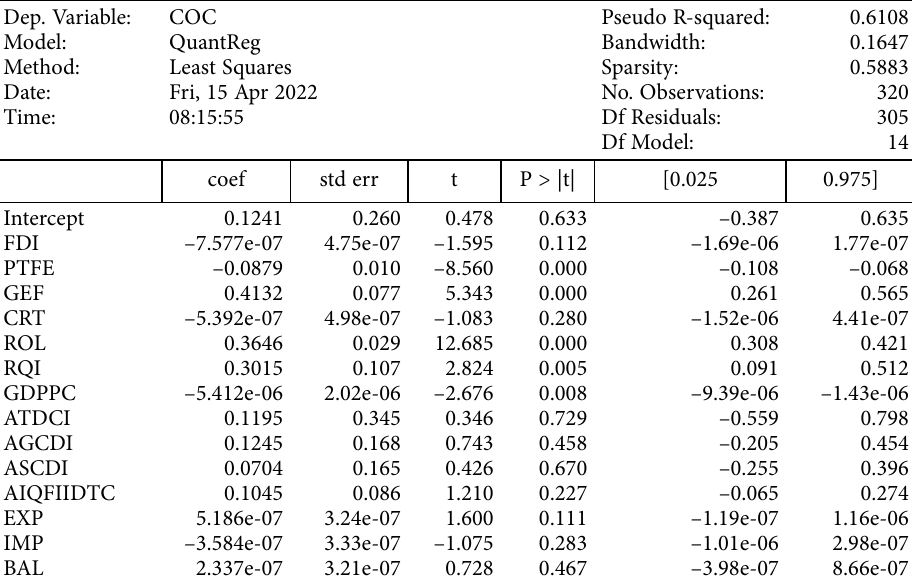
Table 12. QuantReg regression results – Part 2 (source: own processing using Python 3.0